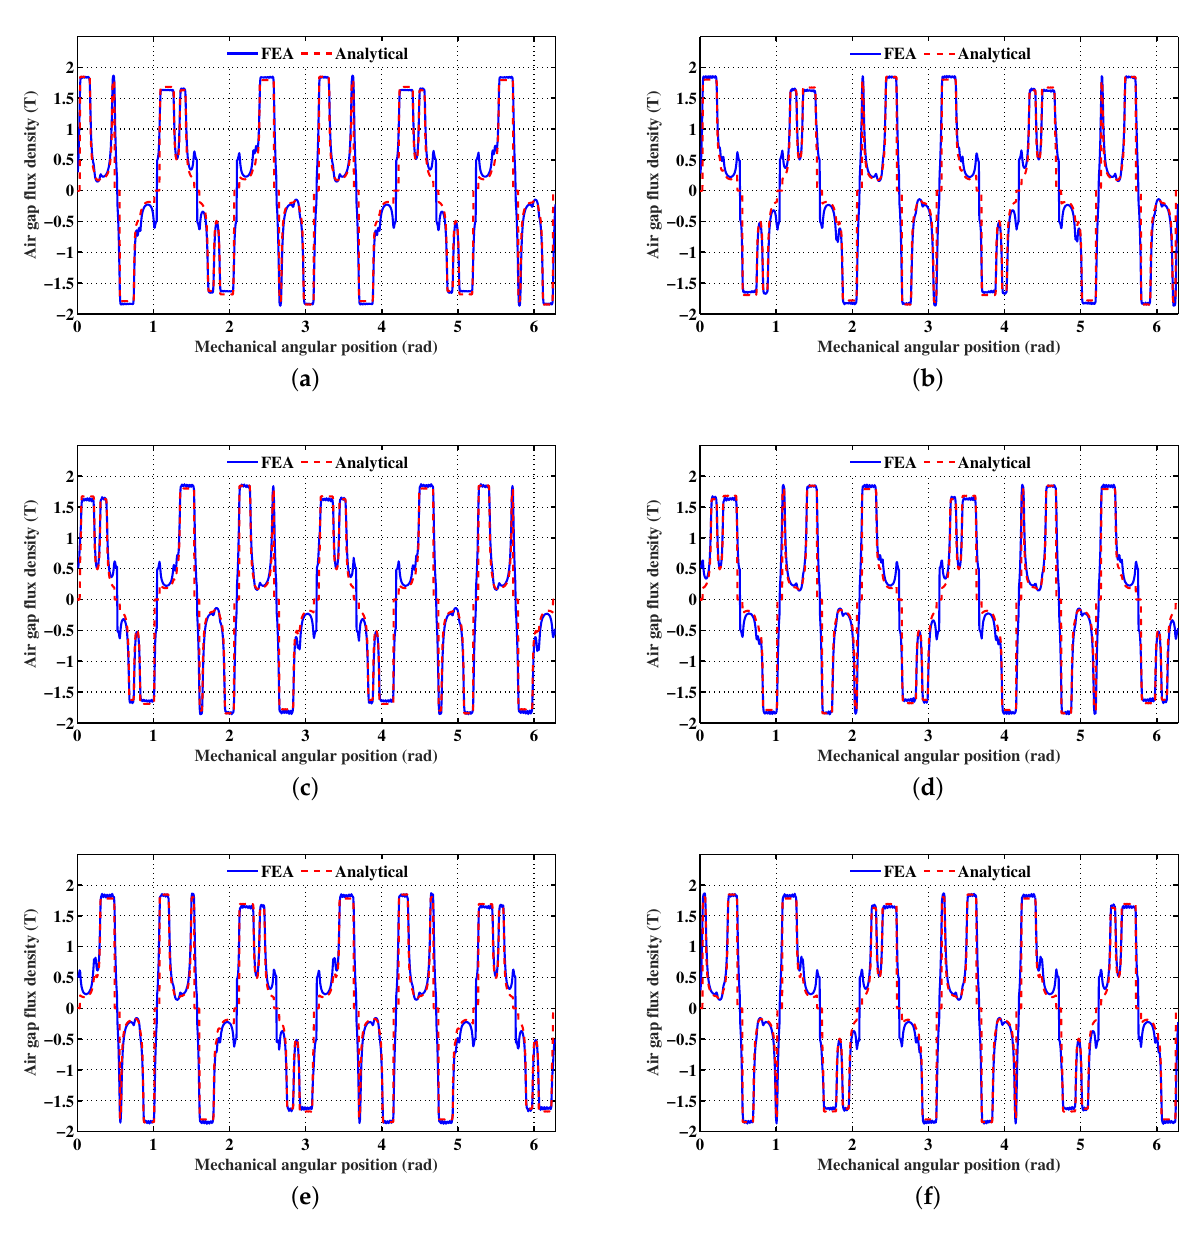
Figure 6. PM flux density spatial repartitions for different rotor positions, with the stator and rotor permeance functions and the rotor position correction function taken into account. Legend: ( a ) θ r = 0 ◦ , ( b ) θ r = 5.4 ◦ , ( c ) θ r = 12.6 ◦ , ( d ) θ r = 18 ◦ , ( e ) θ r = 23.4 ◦ , ( f ) θ r = 30.6 ◦